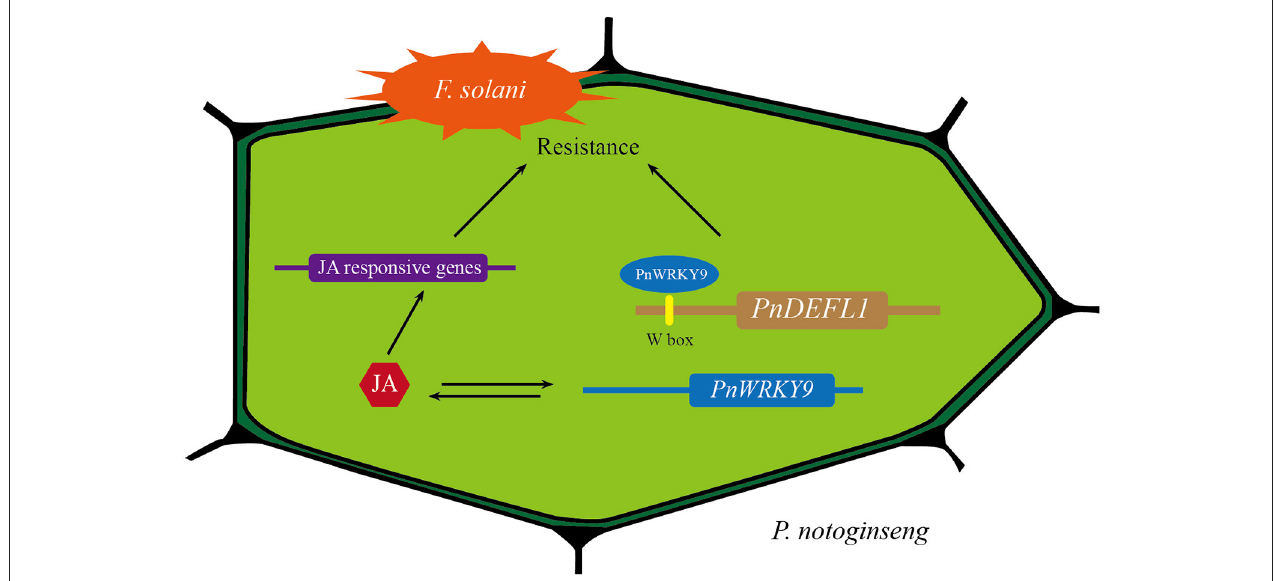
FIGURE 9 | A model of positive regulation of PnWRKY9 in P. notoginseng in response to F. solani infection. After P. notoginseng was infected by root rot pathogen F. solani , PnWRKY9 activated the expression of JA-responsive resistance gene PnDEFL1 by specifically binding W-box in PnDEFL1 promoter, which enhanced resistance to F. solani . Moreover, the activated JA signaling induced the expression of JA-responsive genes to boost defense response against F. solani .